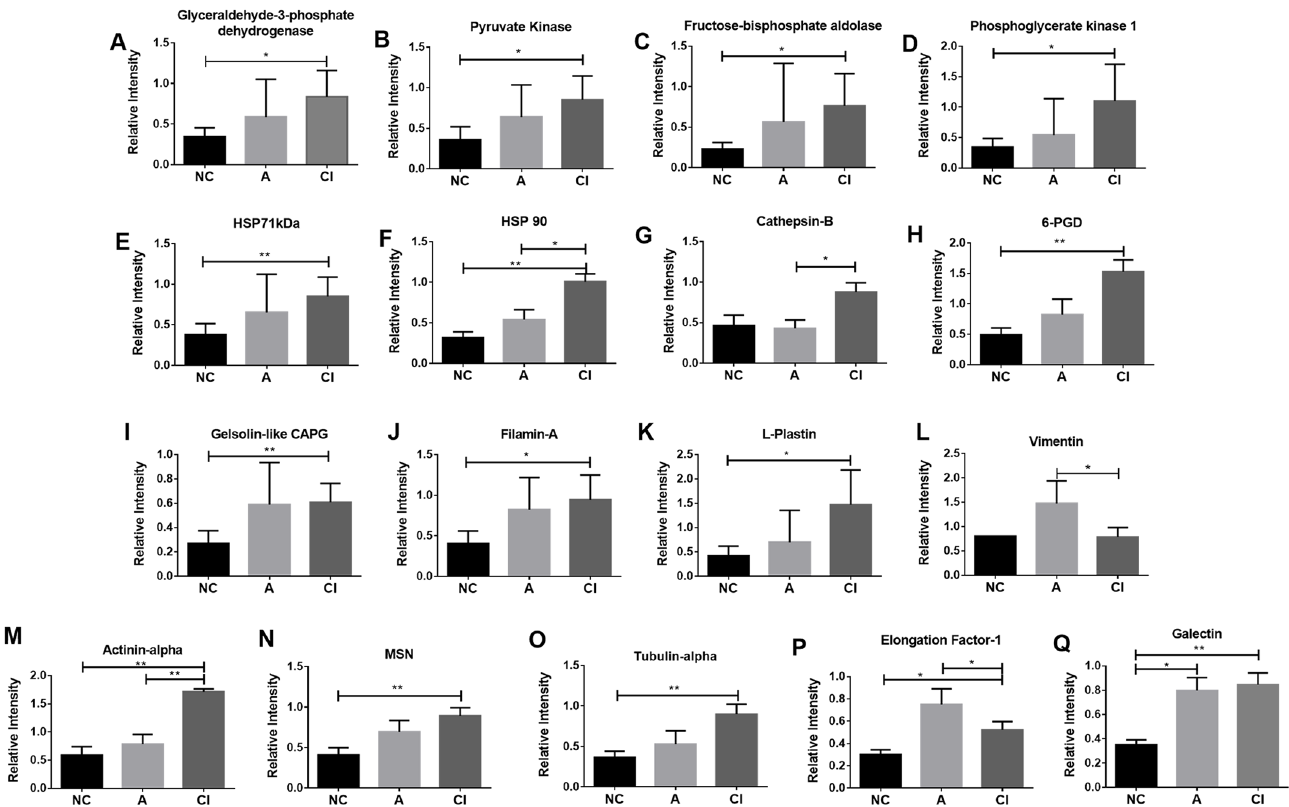
Fig 1. Differentially expressedproteins by TMT and massspectrometry. A-D are proteinsinvolvedin the glycolysis pathway. E and F are the proteins involvedwith cell protection. G is the protein involvedwith neurotoxicity. H, and P are the proteinsinvolvedin oxidativestress and protein synthesis. From I to O are the proteinsinvolvedwith the cell structure and motility. * p < 0.05; ** p < 0.01.